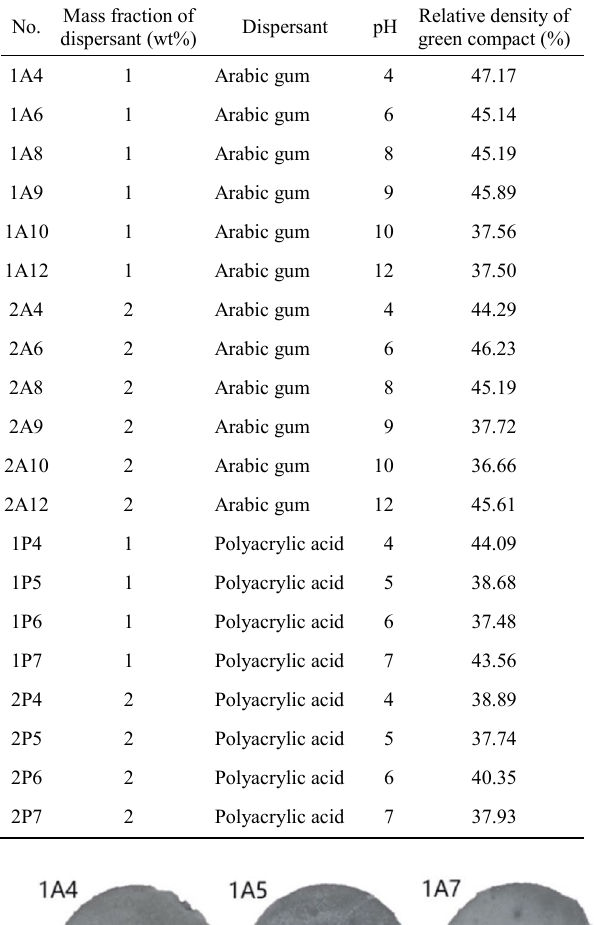
Table 1 Label, dispersant type, mass fraction, pH of Ti 3 AlC 2 suspensions as well as the relative density of Ti 3 AlC 2 green compacts